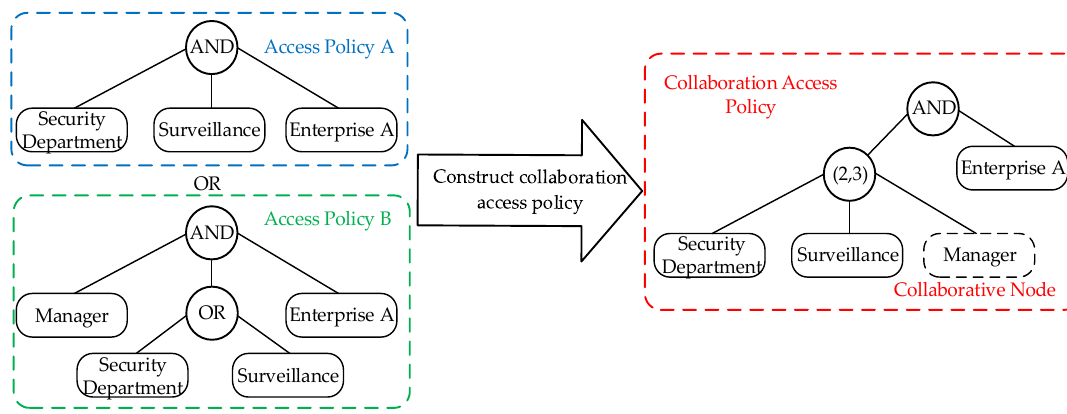
Figure 1. Schematics of the concept of collaboration and the construction of a collaboration access policy.